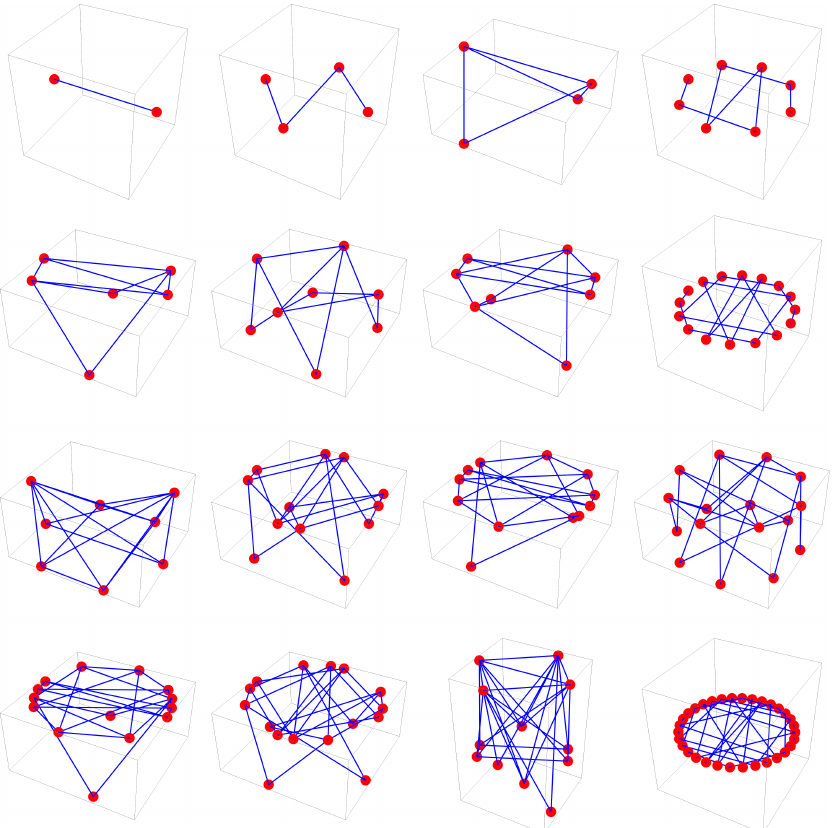
Figure 4. Three-dimensional base space graphs for p = 1 to p = 16 (read left to right, top to bottom). These correspond directly to the graphs in Figure 2, now with the third dimension being the degree of the vertex. In addition to offering a different visual perspective of the p -sequences, the degrees of the vertices within a given graph are intimately related to the nature of p itself and to the values of the centered polygonal lacunary functions at the natural boundary (see text for discussion). Table 1. Characteristics of some important types of three-dimensional base space graphs.